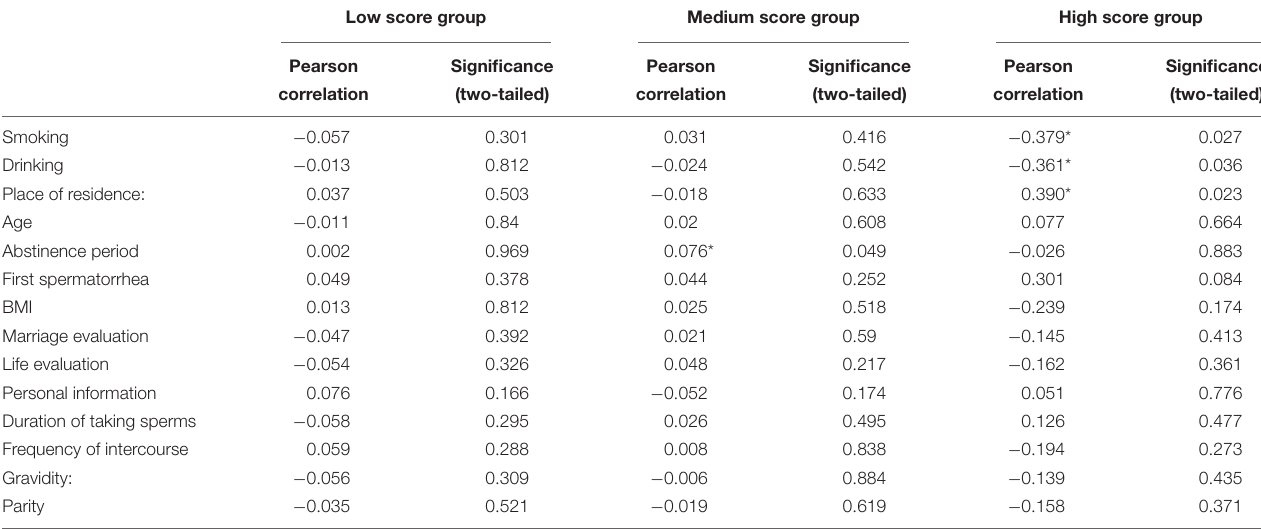
TABLE 5 | Correlation detection of semen quality influencing factors in different